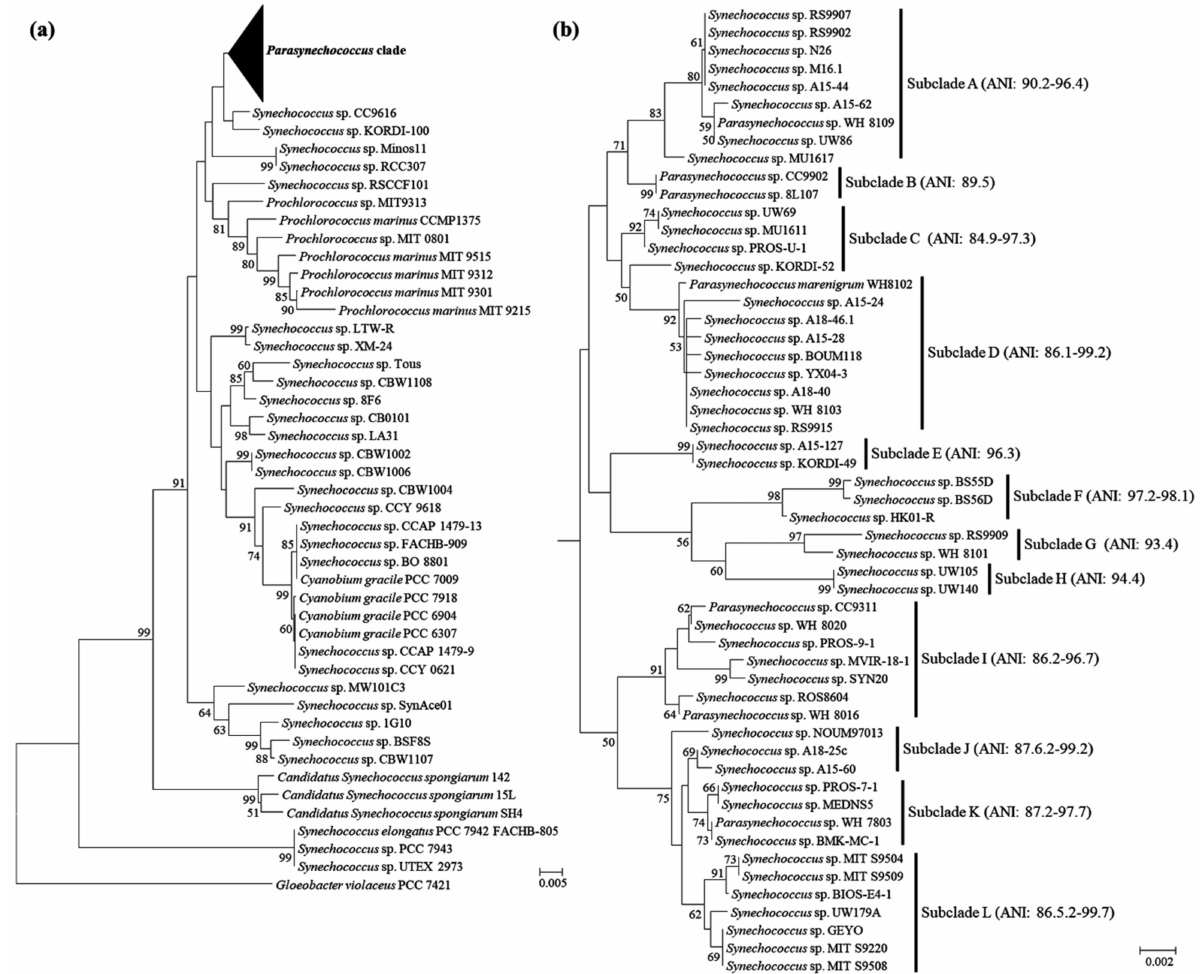
Figure 1. Phylogenetic tree ( a ) of 16S rRNA gene sequences. Parasynechococcus clade was shown in subtree ( b ). The ANI values among strains within subclades were shown in brackets. The scale bar indicated substitutions per